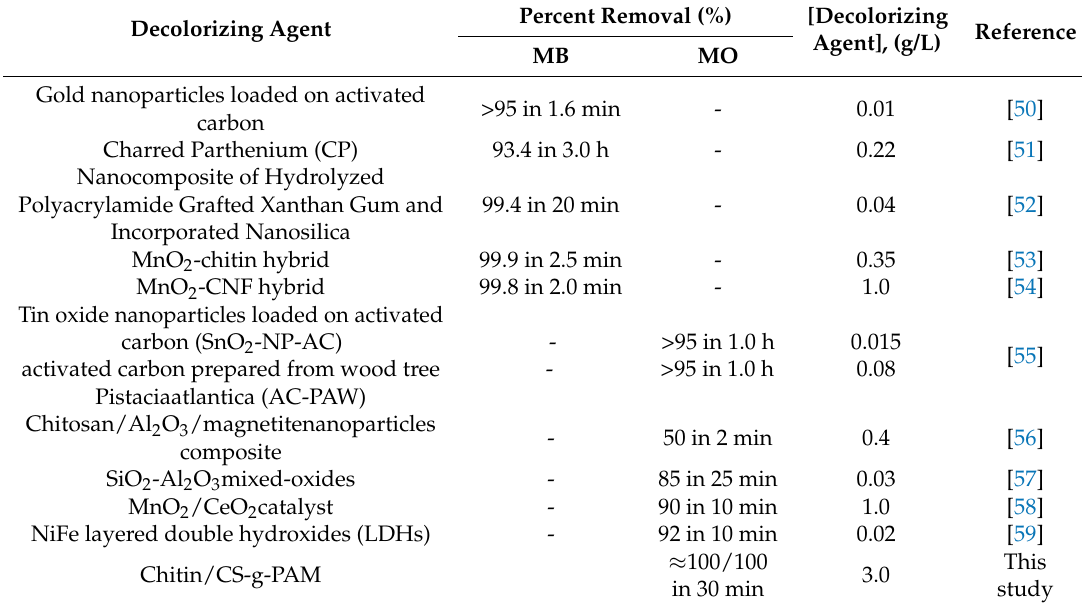
Figure 6. Pictures of the total decolorization of dyes solution: initial MB/MO concentration: 1.0 mg/L; CS-g-PAM/CH concentration: 0.3 g·100 mL − 1 ; 25 °C. Table 2. Comparison of percent removal of MB and MO by CH and CS-g-PAM with different adsorbent materials including CH and CS-g-PAM.